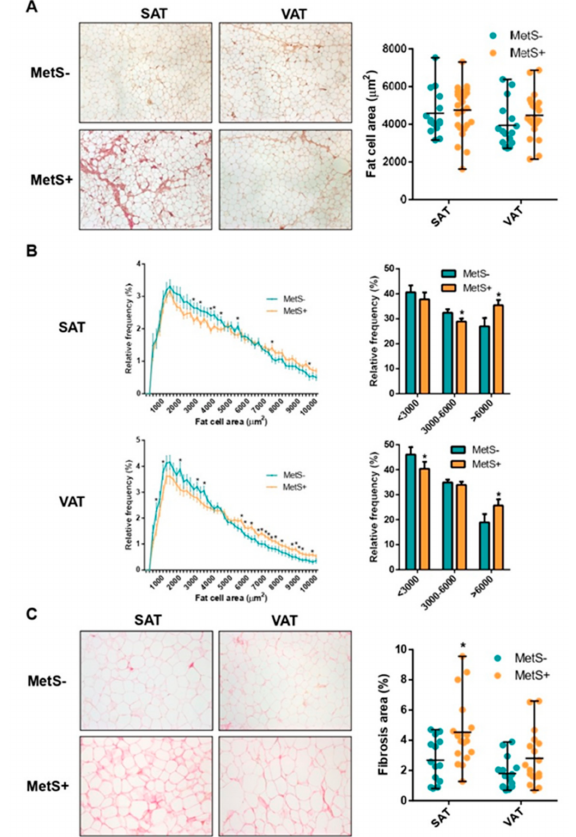
Figure 1. Fat cell size distribution and fibrosis. Comparison of adipocyte cell surface area and representative images ( A ) of SAT and VAT samples from MetS − and MetS+ individuals. Frequency distribution analysis of fat cell areas divided by size into bin intervals of 200 µ m 2 and into three representative sizes ( B ). Data are presented as the average ± SD frequencies of cells within each bin and compared by the Holm–Sidak t -test for multiple comparisons or by Welch’s t -test among size intervals. Comparison of histological pericellular fibrosis and representative images ( C ). Data are presented as the ratio of fibrous tissue area stained with picrosirius red/total tissue surface. SAT, subcutaneous adipose tissue; VAT, visceral adipose tissue; MetS − , severely obese without MetS; MetS+, severely obese with MetS. * = p <